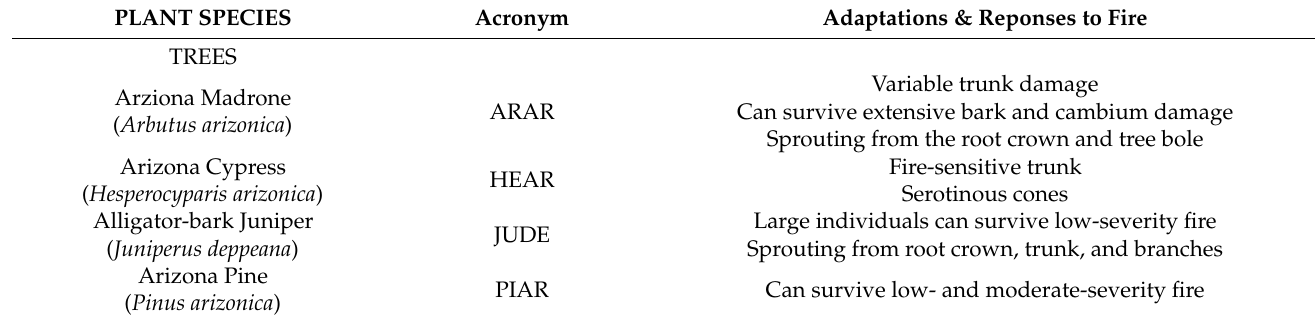
Table A2. Species Latin names, acronyms, and adaptations and responses to fire of common trees and shrubs in Chiricahua National Monument (Sources: USDA Fire Effects Information System; Barton 1999, 2002; Gebow 2005; Barton and Poulos